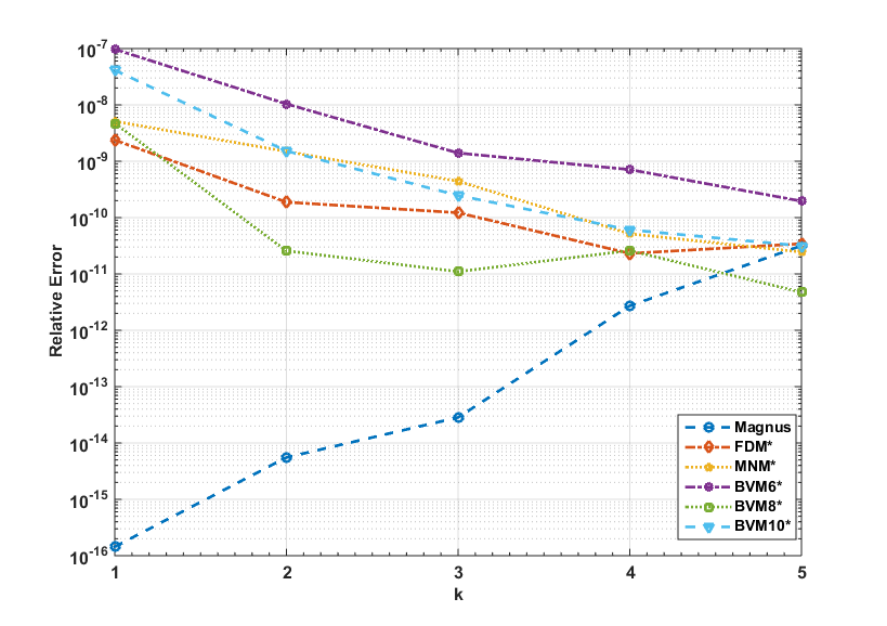
Figure 4. Log relative error of the first five eigenvalues of the problem in Equation (32).